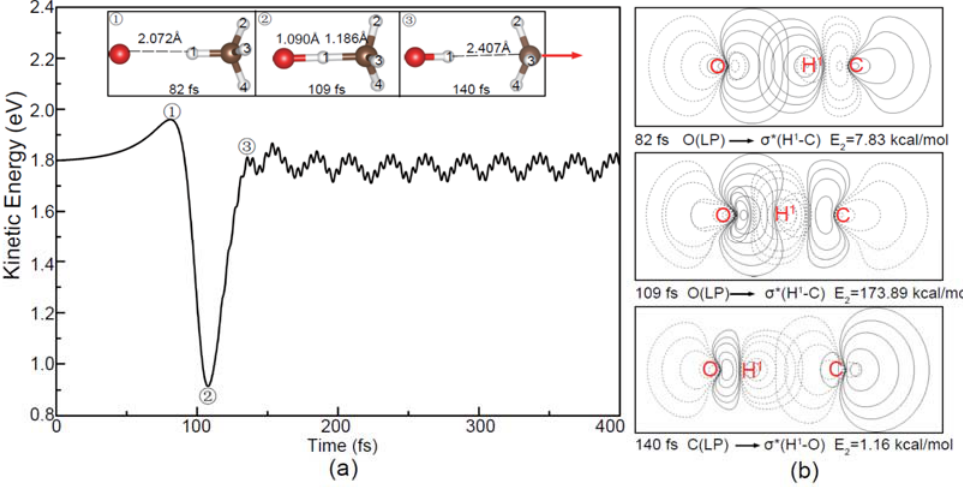
Figure 3. ( a ) Evolution of the total kinetic energy and snapshots in the reaction beginning with the O − apex attack (1.8 eV); ( b ) The corresponding natural bond orbital (NBO) contour maps at the selected times and E 2 is the hyperconjugative energy. The red arrow in ( a ) shows the translational direction of the product CH 3 .